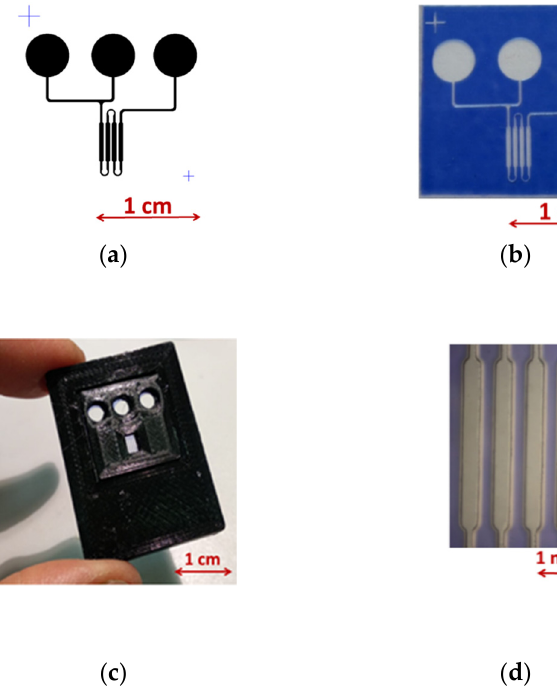
Figure 6. The biosensor design. Microfluidic system topology ( a ), SEM photograph of relief in the channel formed in photoresist film ( b ), view of biosensor ( c ), working channels ( d ), of the optical module for signal registration ( e ).